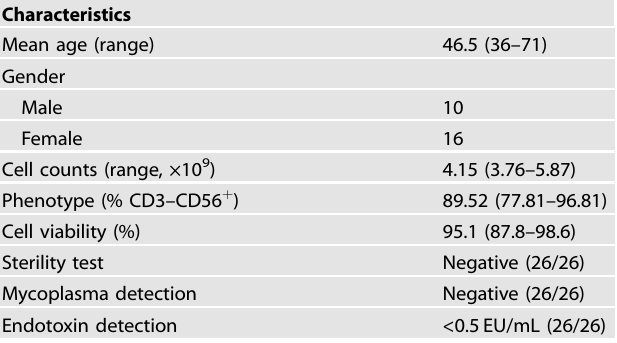
Table 1. Clinical characteristics of 26 individuals receiving NK cells